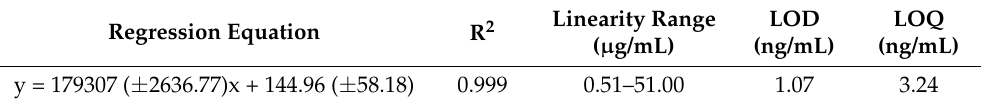
Table 2. Regression equation, R 2 , limit of detection (LOD), and limit of quantification (LOQ) of β -carotene analyzed by HPLC-DAD.